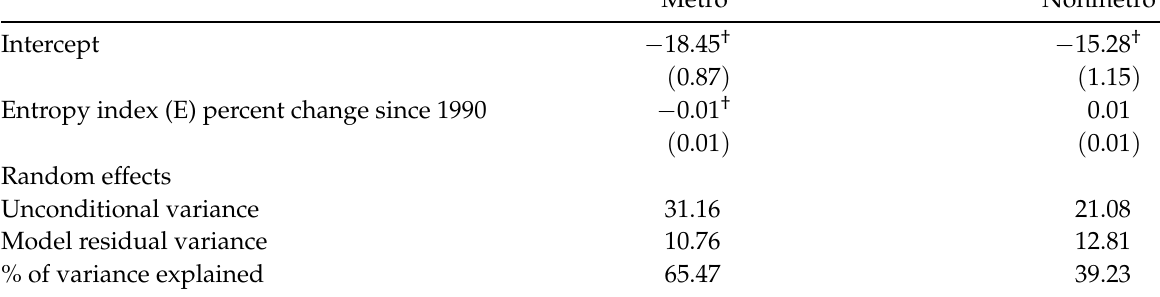
1990-2010 Place transition (gain diversity as